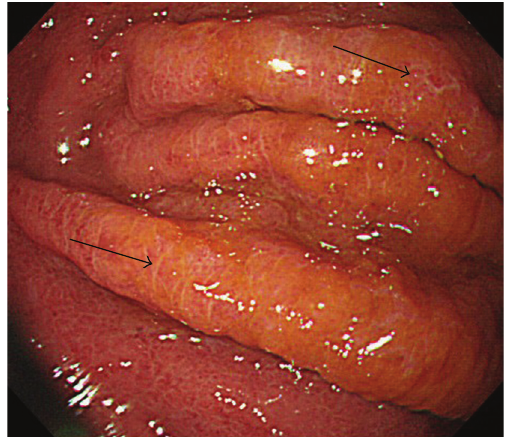
Figure 2: Gastric mucosal changes caused by Lugol’s solution in a 58-year-old man. The reticular pattern of white lines on the thickened folds is shown by the arrows.